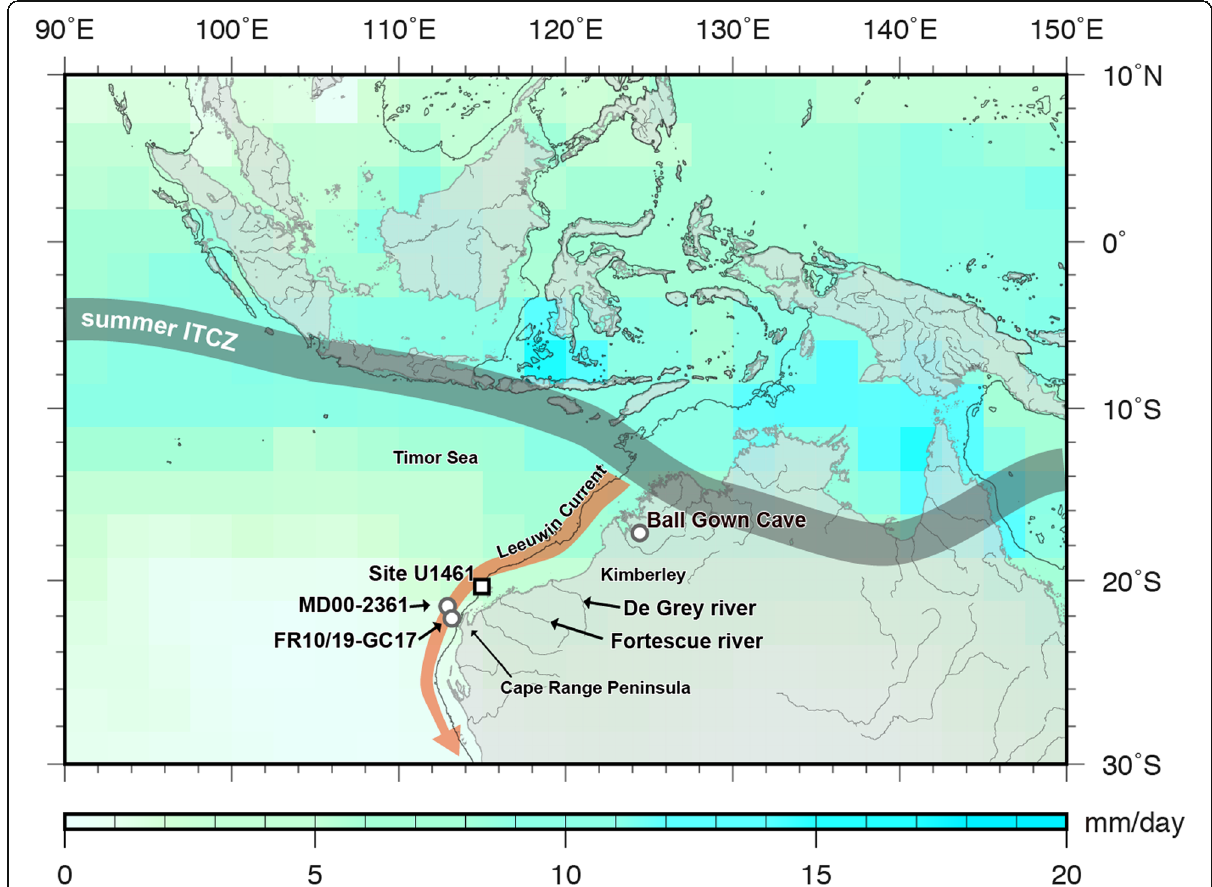
Fig. 1 The location map of site U1461 with 200 m water depth contour from ETOPO dataset (Amante and Eakins 2009) and a monthly rate of precipitation in the tropical Indo-Pacific region. Rivers are shown with thin black lines (data obtained from a Global Self-consistent, Hierarchical, High-resolution Geography Database after Wessel and Smith 1996). Austral summer daily precipitation data were obtained from the Global Precipitation Climatology Project (Huffman et al. 1997), indicating that Site U1461 locates the southern limit of rain belt. Locations of the discussed records from Ball Gown Cave (Denniston et al. 2013), MD00-2361, and FR10/19-GC17 (De Deckker et al. 2014; Stuut et al. 2014) are shown on the map. Figures were drawn using The Generic Mapping Tools (Wessel et al.